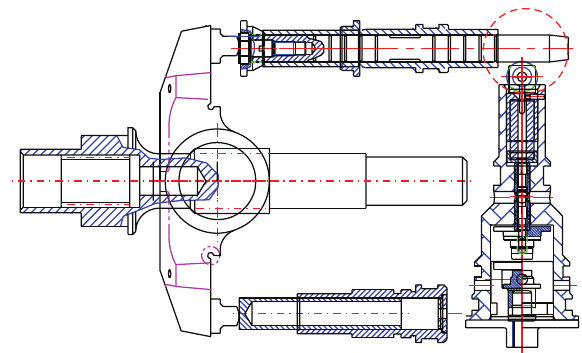
Figure 12: Schematic of VDAPP in the case of flow rate cut-off.